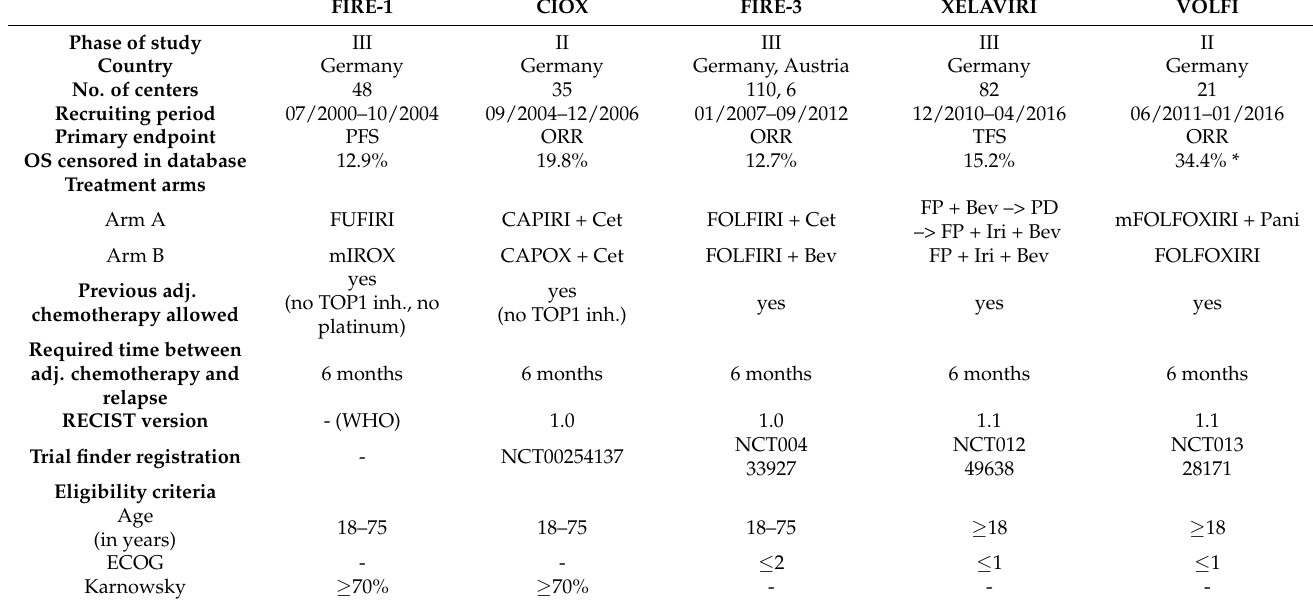
Table 1. Characteristics of the five studies included in the pooled